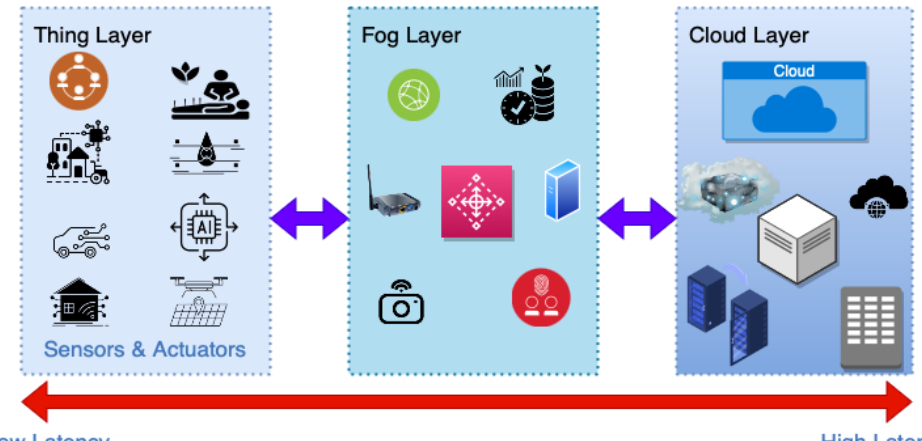
Figure 1. A three-layer Internet of Things (IoT)